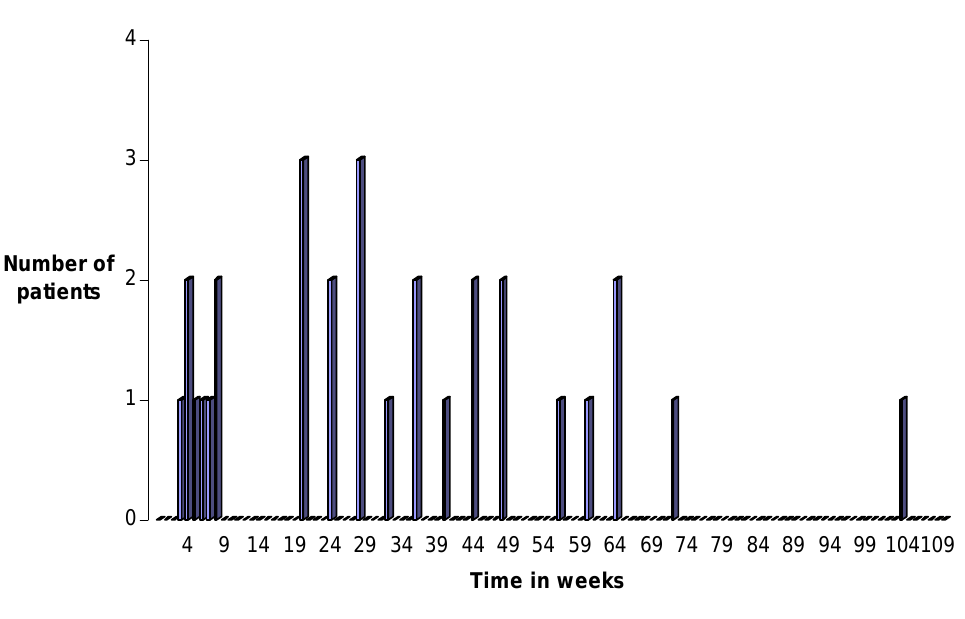
FIGURE 3. Spectrum of elapsed time between tenofovir initiation and detection of renal insufficiency in cases reported in the